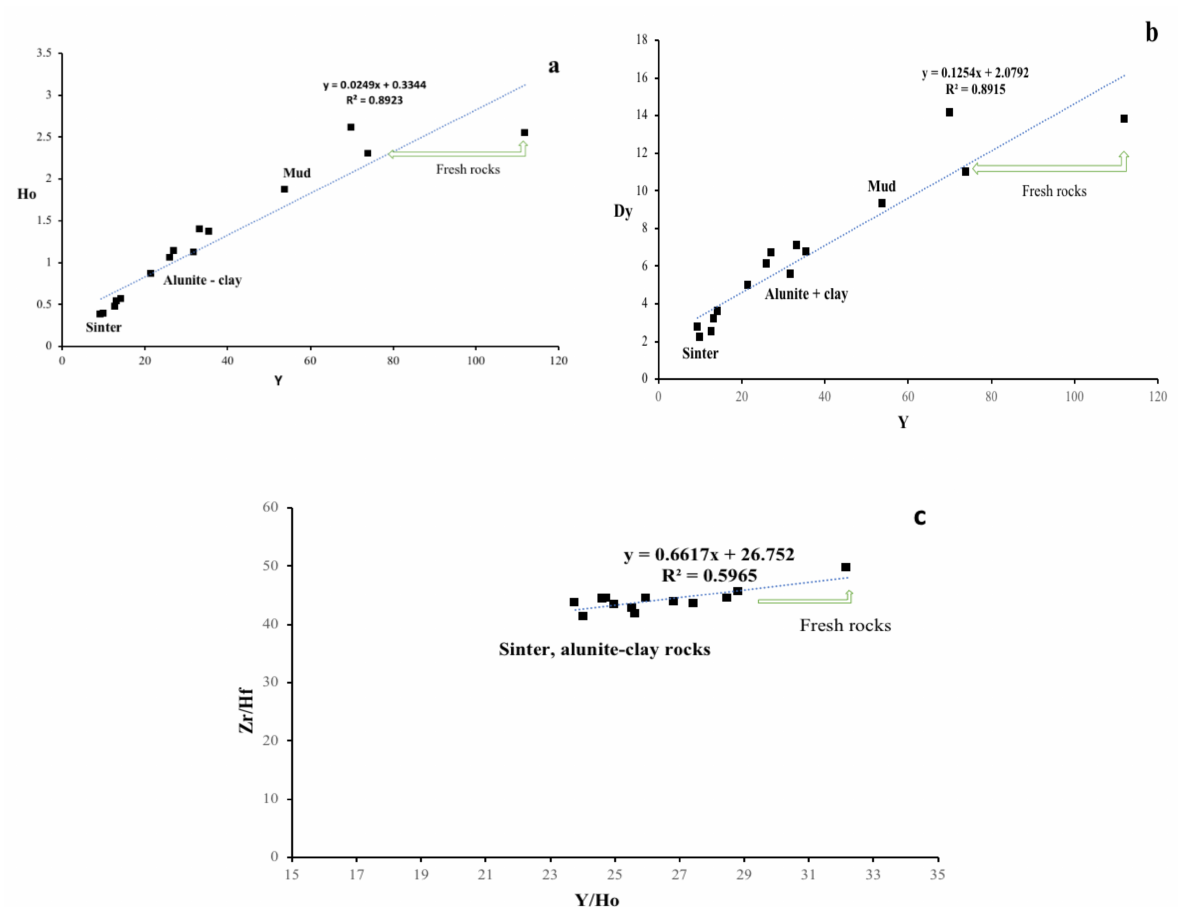
Figure 8. The diagram of Y vs. Ho ( a ), Y vs. Dy ( b ) and Y/Ho vs. Zr/Hf ( c ) corresponding to sinter, alunite-clay and fresh